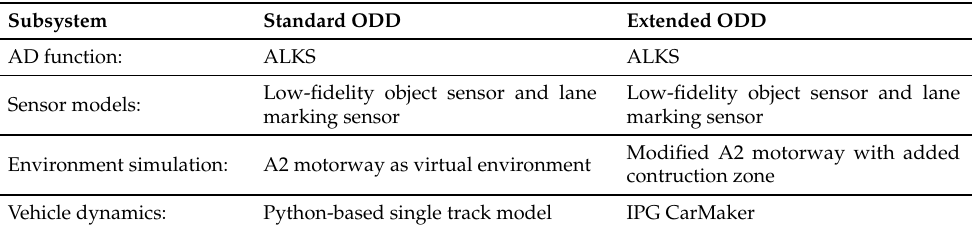
Table 5. Overview of the concrete subsystems for both simulation frameworks (for the standard and the extended